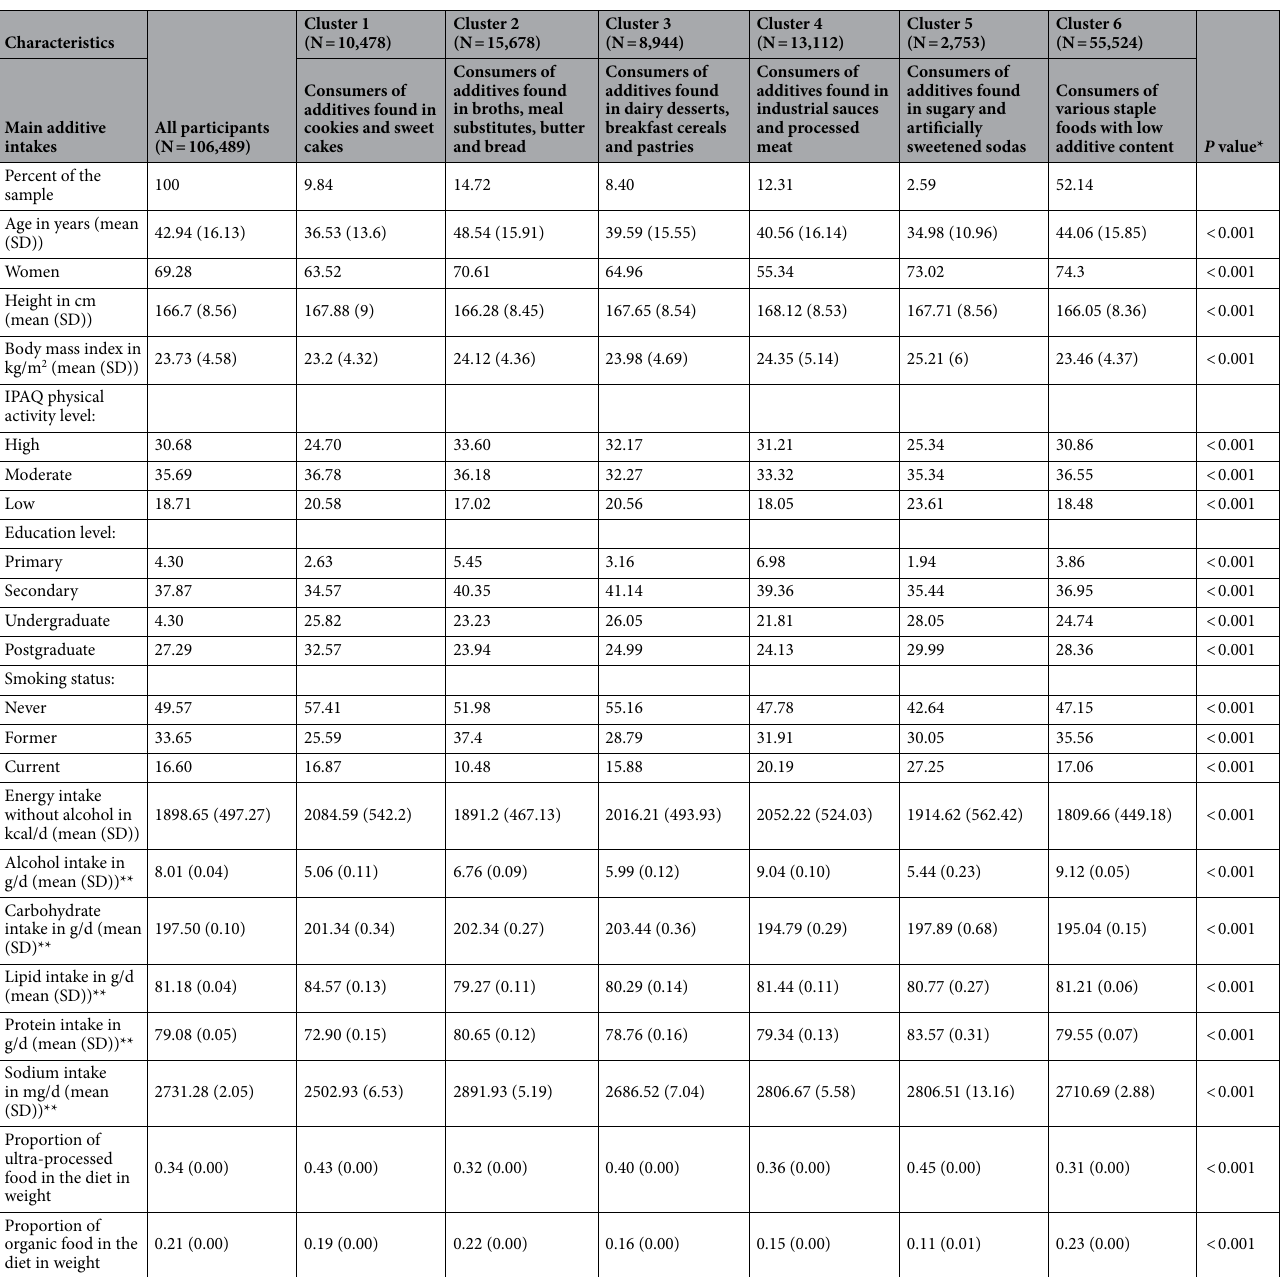
Table 2. Sociodemographic and lifestyle characteristics of clusters of food additive consumers, NutriNet-Santé cohort, France, 2009–2020 (N = 106,489). Weighted according to the French national census report data by using the CALMAR macro run by sex and based on age, socio-professional category and housing area 69 . Values are percentages unless stated otherwise. IPAQ was available for 91,675 participants, education for 99,725, smoking status for 106,242 and proportion of organic food for 28,075 participants. *Comparisons between clusters using Chi-square tests or linear regressions, as appropriate. **Adjusted for energy intake and number of 24 h dietary